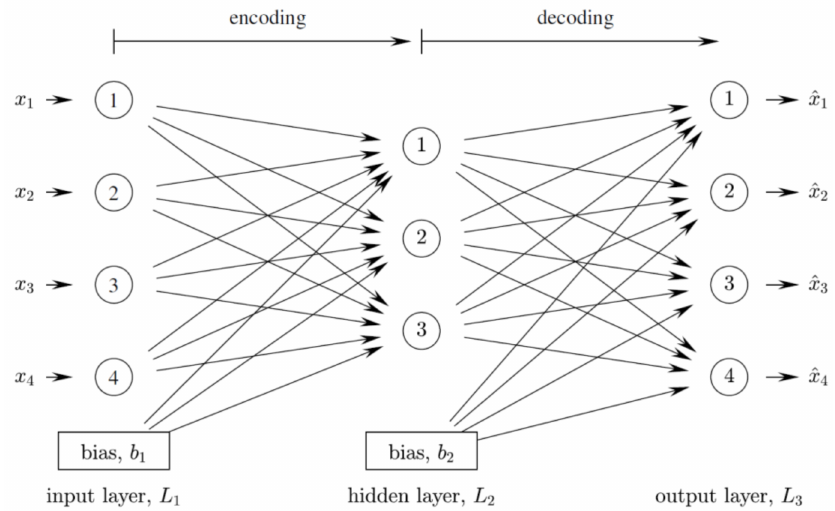
Figure 2. Simplified typical neural network architecture to implement an